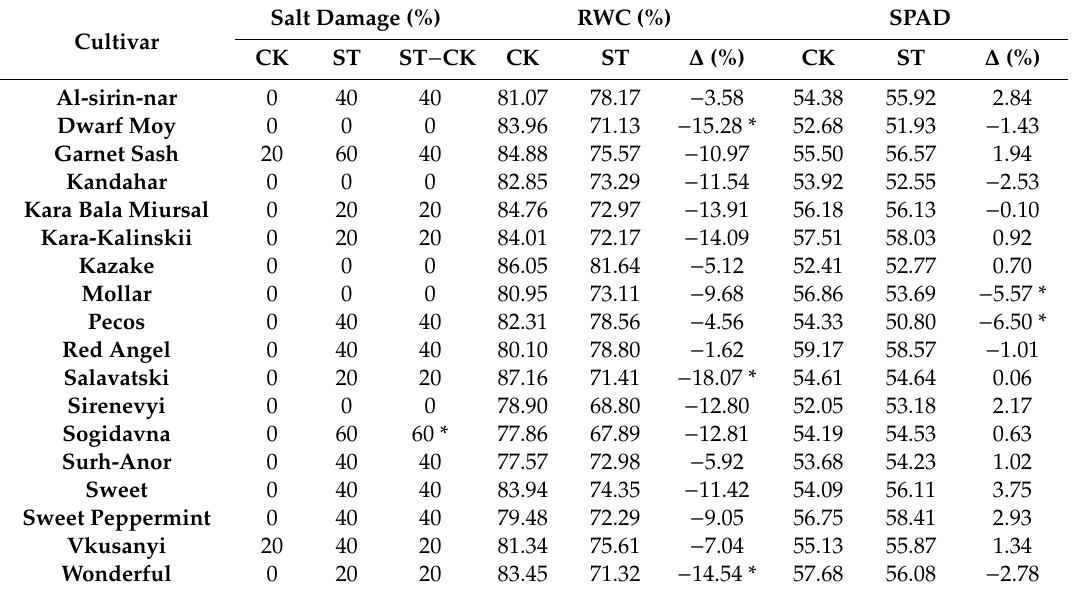
Table 3. Salt damage, relative water content (RWC), and soil–plant analyses development (SPAD) of pomegranate leaves under NaCl